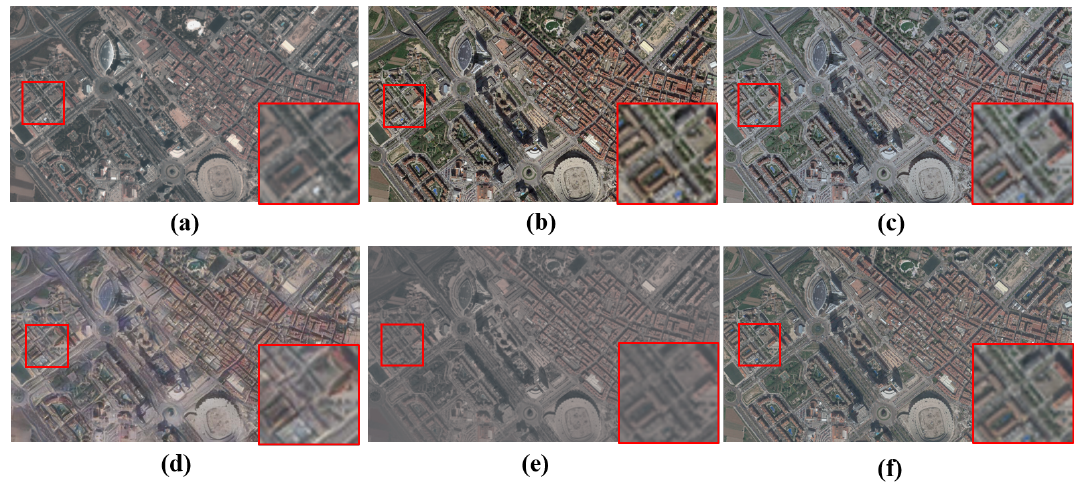
Figure 8. Reference images of the clip park. ( a ) Sample frame I f from the satellite video clip park; ( b ) reference image I g after geometric matching; ( c ) reference image from I g after color transform [2]; ( d ) reference image from I g after adaptive instance normalization (AdaIN) [40]; ( e ) reference image from I g after PhotoWCT [43]; ( f ) reference image from I g after image translation using the proposed method.